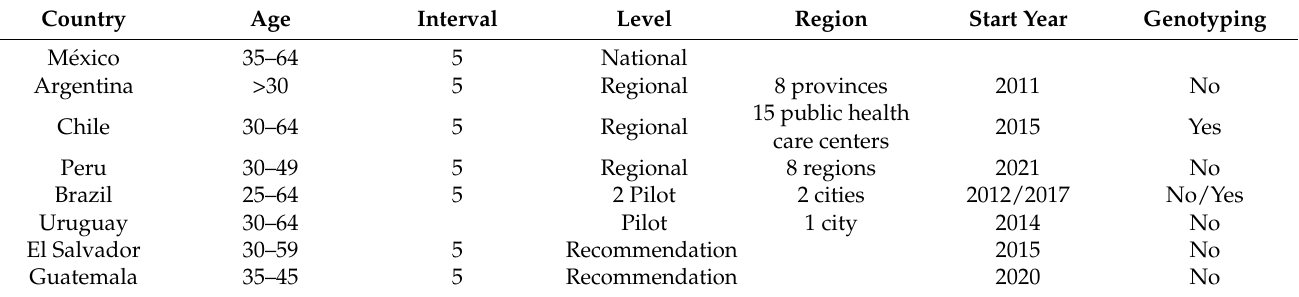
Table 1. Information about HPV-based screening implementation in eight Latin American